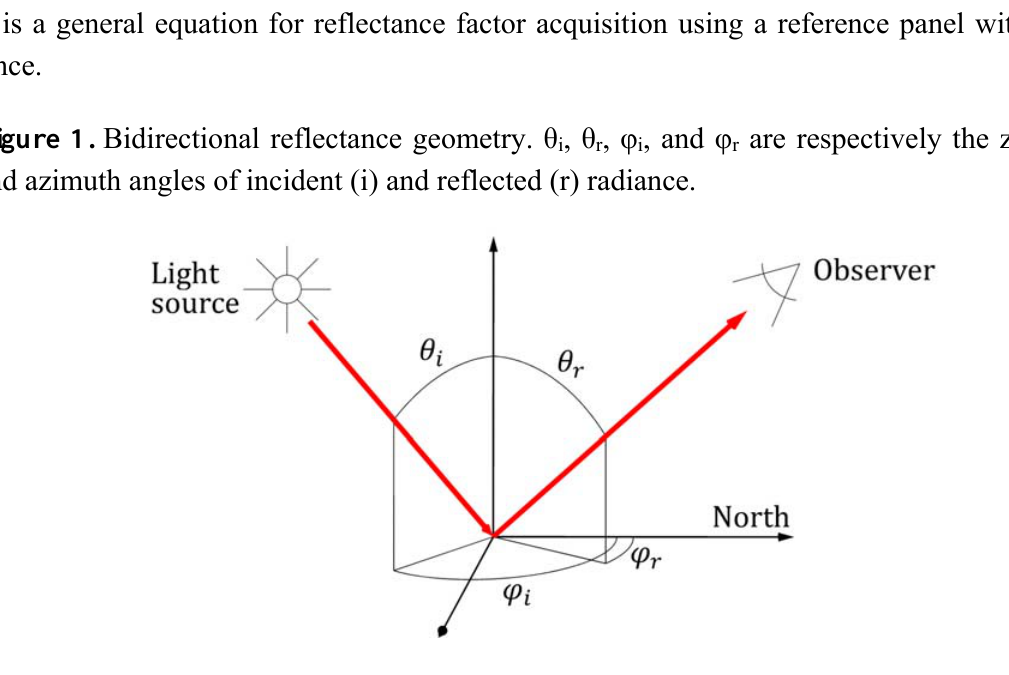
, θ , φ , and φ are respectively the zenith i r i r